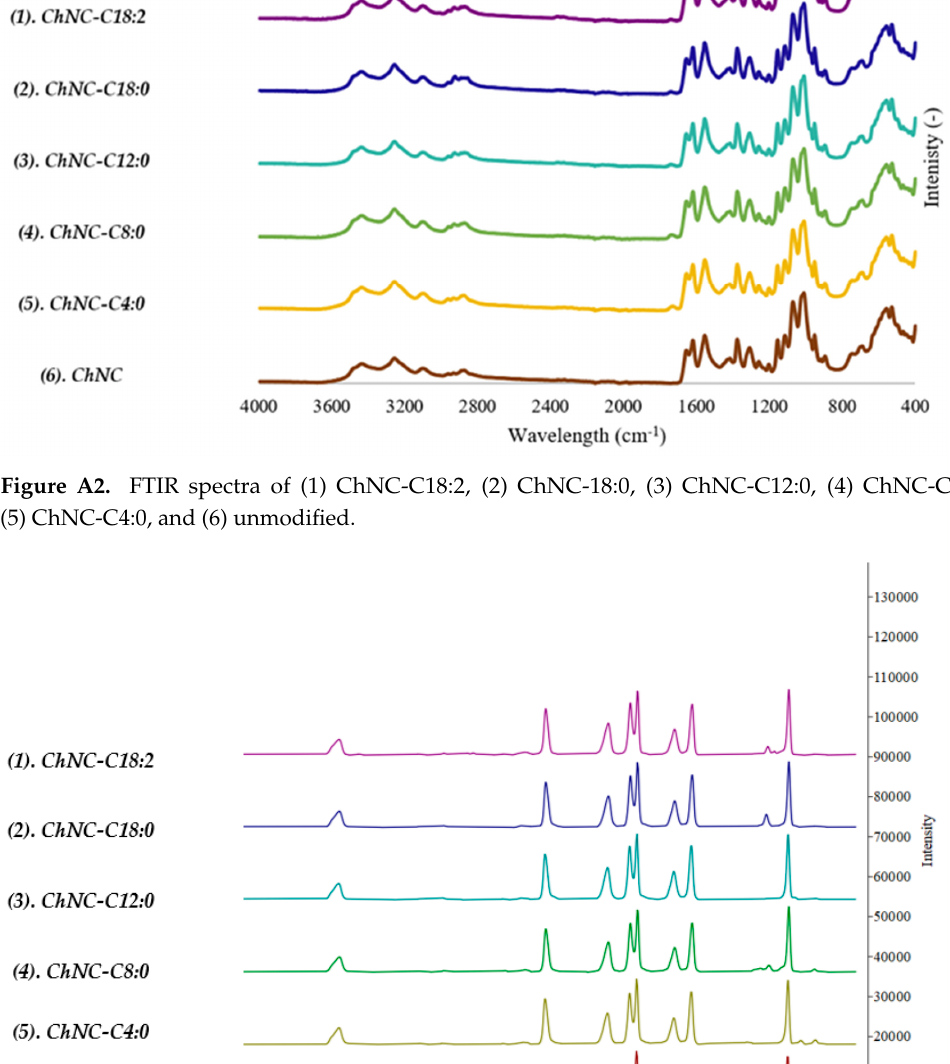
Figure A3. 13 C-NMR Spectra of (1) ChNC-C18:2, (2) ChNC-18:0, (3) ChNC-C12:0, (4) ChNC-C8:0, (5) ChNC-C4:0, and (6) Unmodified ChNC.